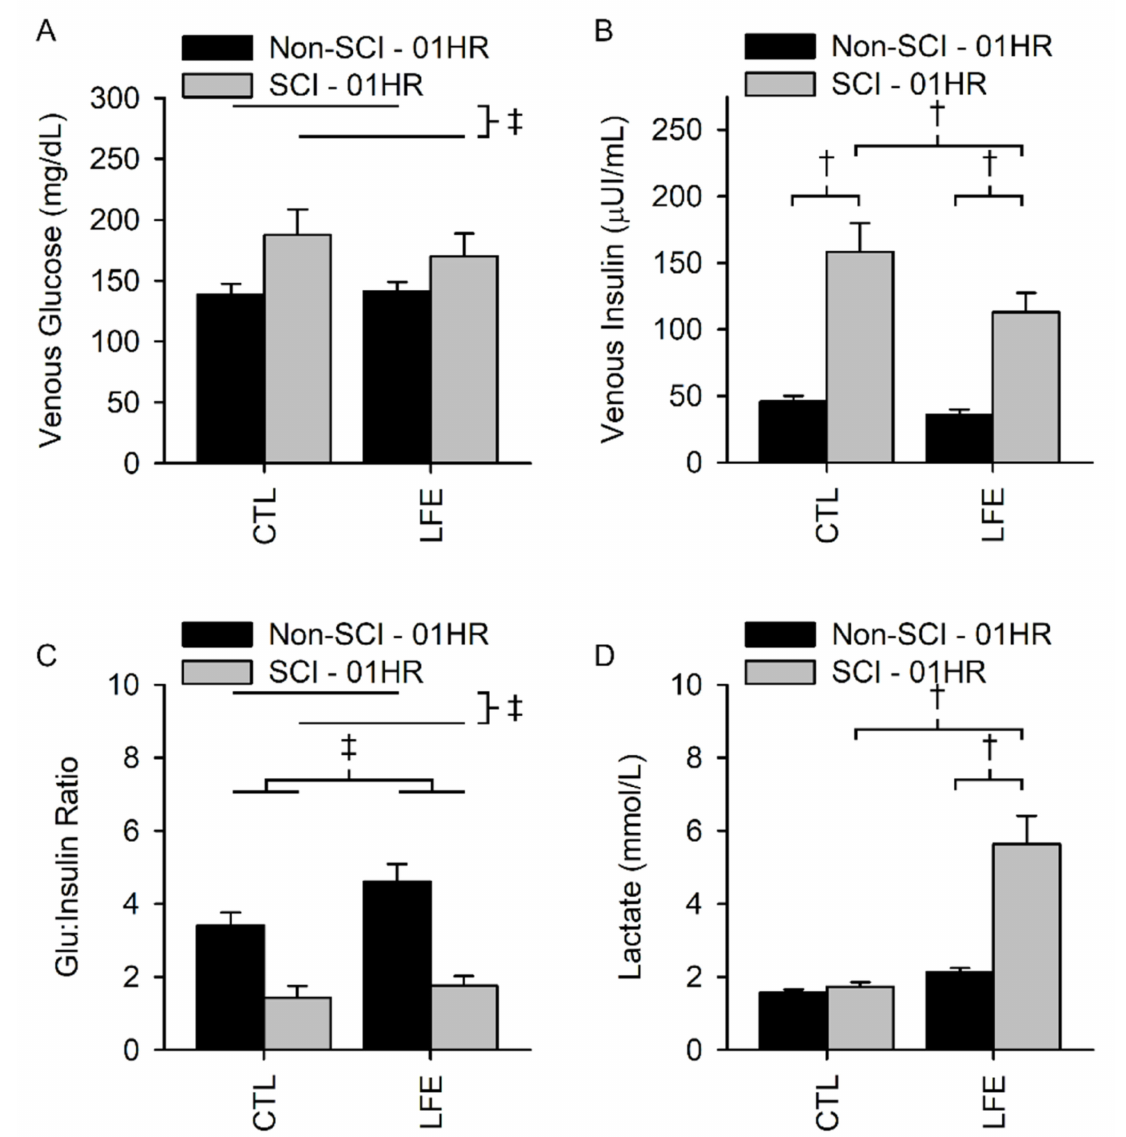
Figure 3. 1-h venous blood biomarkers. There was no interaction for glucose ( A ) and the glucose to insulin ratio ( C ). However, people with SCI had a higher glucose response than those without SCI. The glucose to insulin ratio was higher after LFE for both people with and without SCI, though the ratio was lower for people with SCI during both CTL and LFE sessions. There was a significant interaction for insulin ( B ) and lactate ( D ). Insulin was significantly lower after LFE for people with SCI even though their insulin levels were higher than the non-SCI cohort for both the LFE and CTL sessions. Lactate was significantly higher in people with SCI after LFE compared to their control session and compared to the non-SCI cohort after LFE. † Indicates a significant difference ( p ≤ 0.05) of the indicated simple effect during post hoc testing due to a significant interaction between population and session. ‡ Indicates a significant difference ( p ≤ 0.05) of the indicated main effect and no significant interaction between session and